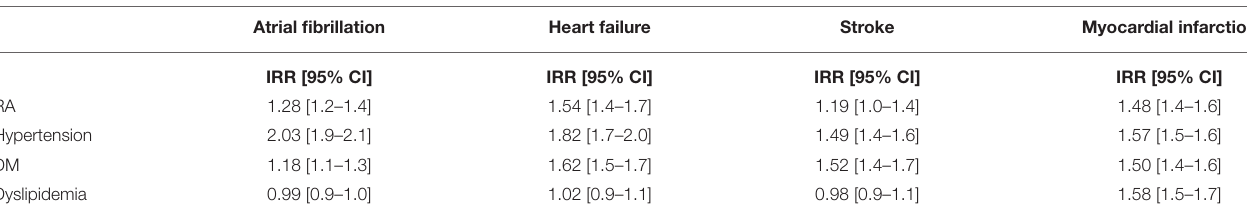
TABLE 2 | Assessment of the relationship between CV risk factors and CV